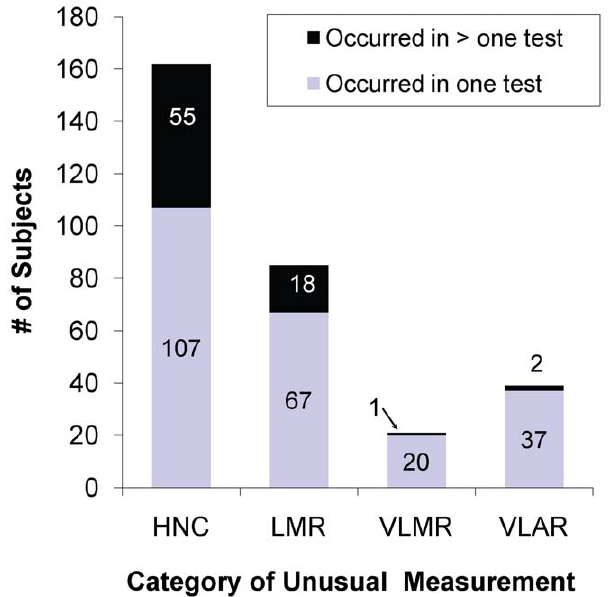
Figure 2. Number of subjects with unusual IFN- c measure- ments when QuantiFERON-TB Gold tests were repeated. The number of subjects with unusual IFN- c measurements categorized as High Nil Concentration ( HNC ), Low Mitogen Response ( LMR ), Very Low Mitogen Response ( VLMR ), and Very Low Antigen Response ( VLAR ) that occurred only with the initial test (light gray bars), with the repeat test (dark gray bars), or in both the initial and repeat test (medium gray bars) among 1,044 Subjects with Initial and Repeat QuantiFERON-TB Gold Test Results.